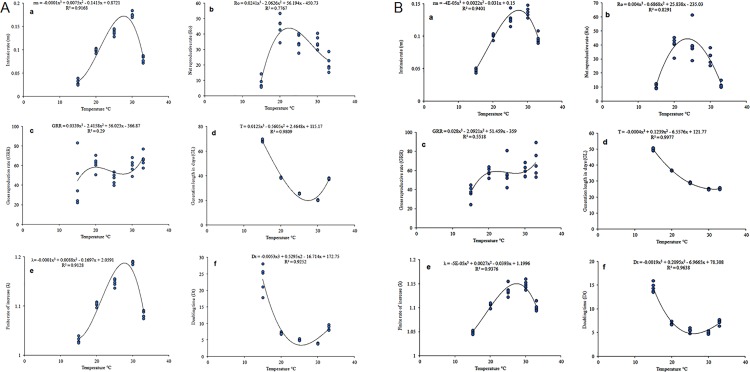
Life table parameters of C. rosa (5a) and C. quilicii (5b) estimated through model prediction over a range of six constant temperatures: Intrinsic rate of increase, rm; net reproduction rate, Ro; gross reproductive rate, GRR; mean generation time, T; finite rate of increase, λ; and doubling time, Dt.